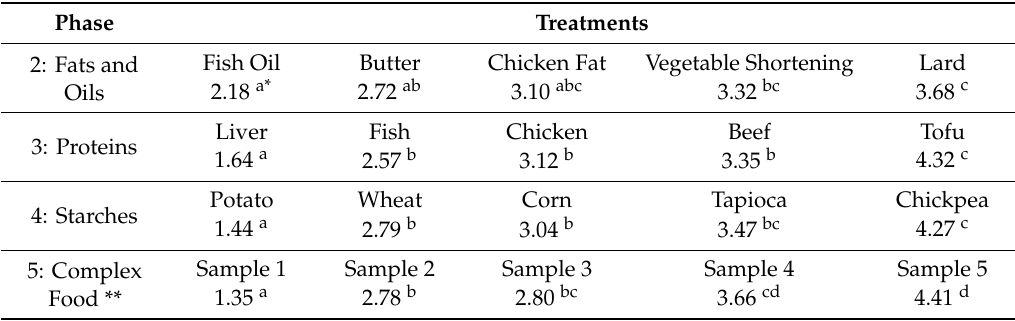
Table 3. The e ff ect of di ff erent treatments (fat, protein, starch, and complex food) on rank order preference in dogs in phases 2–5.